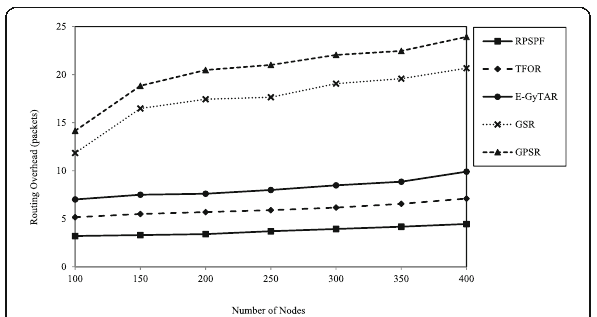
Fig. 11 Routing overhead as function of packet sending rate (400 nodes). RPSPF represents Reliable Path Selection and Packet Forwarding Routing Protocol which is proposed approach and is represented by a solid line with a square. TFOR is traffic flow- oriented routing protocol and is represented by a dashed line having rhombus. E-GyTAR is Enhanced Greedy Traffic Aware Routing protocol and is represented by a solid line with circle. GSR is geographic source routing protocol and is presented by a dotted line having a cross. GPSR is Greedy Perimeter Stateless Routing Protocol and is presented by a dashed line having a triangle